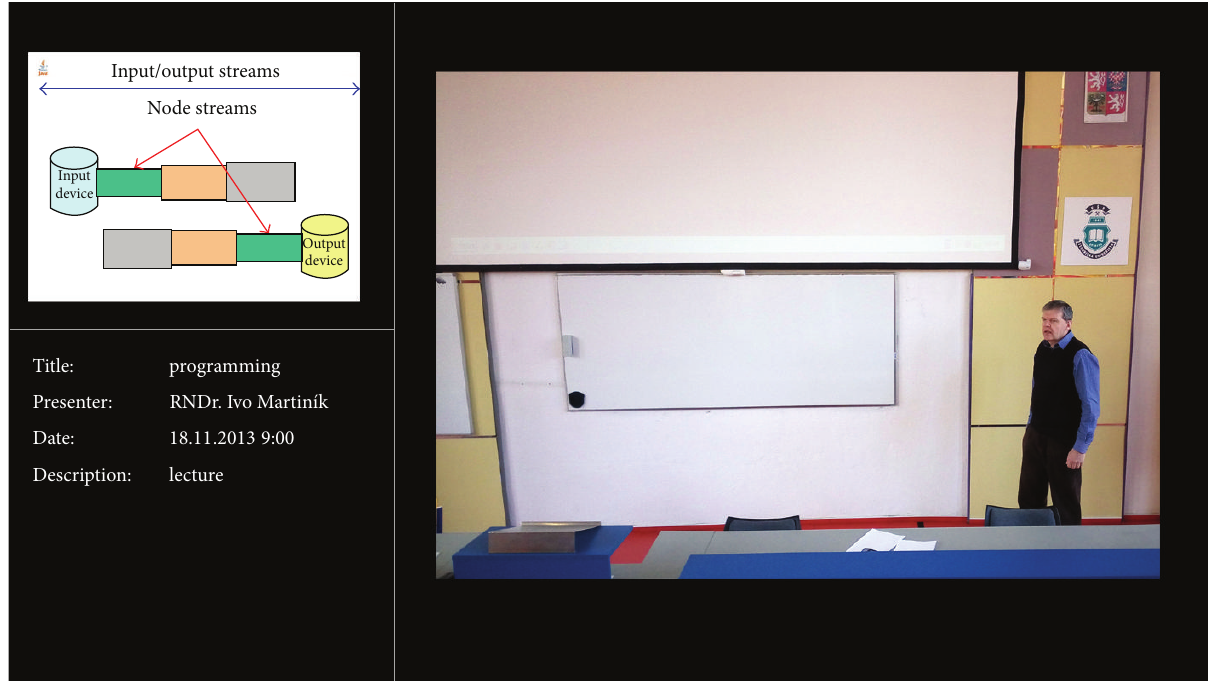
Figure 13: Shot of general-view type in audiovisual lecture room.